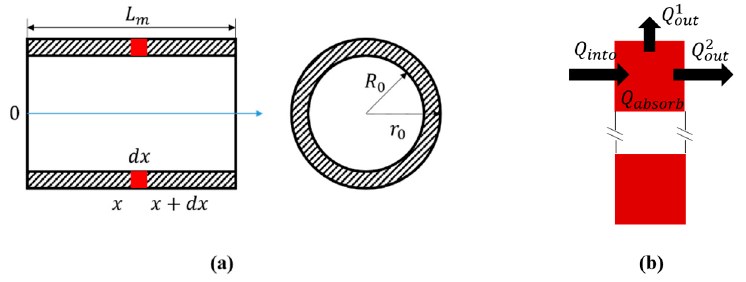
Figure 3. Analysis of heat transfer for the mount: ( a ) cross section of mount, ( b ) the heat transfer path of the dx .